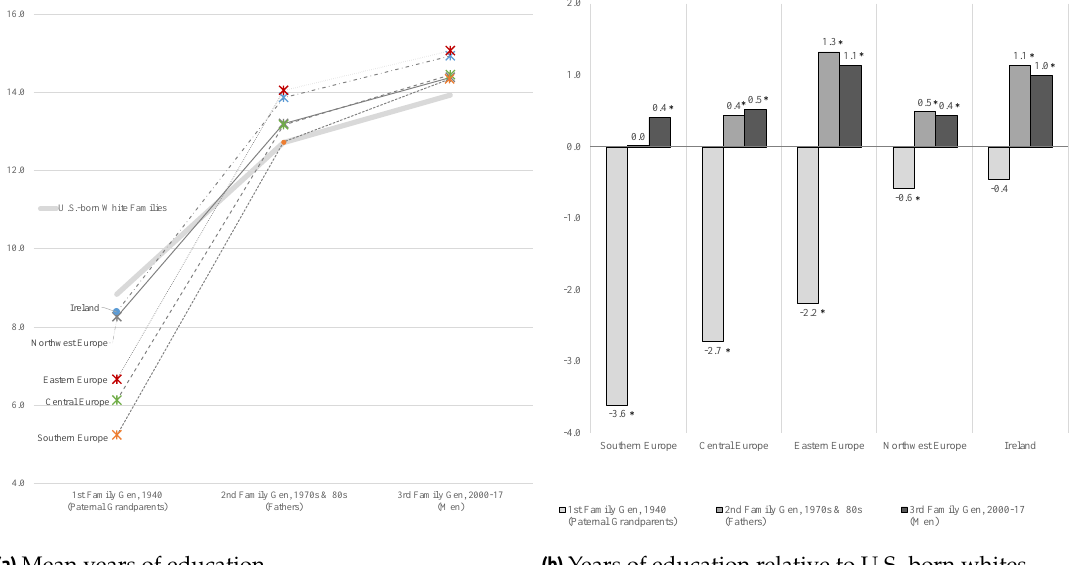
(a) Mean years of education. Figure 3a. Mean Years of Education Figure 3b. Years of Education Relative to U.S.-born Whites Figure 3: Years of education among men by generational status and ethnic origin. *Significant difference between the European immigrant origin and U.S.-born white families